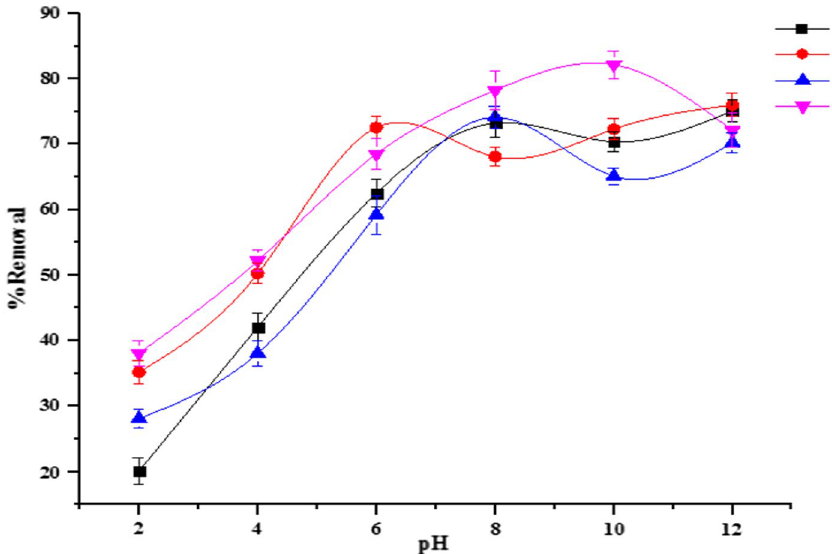
Fig. 5 Effect of pH on the percentage removal of Pb(II), Cd(II), Zn(II) and Cu(II) onto powdered Albizia lebbeck